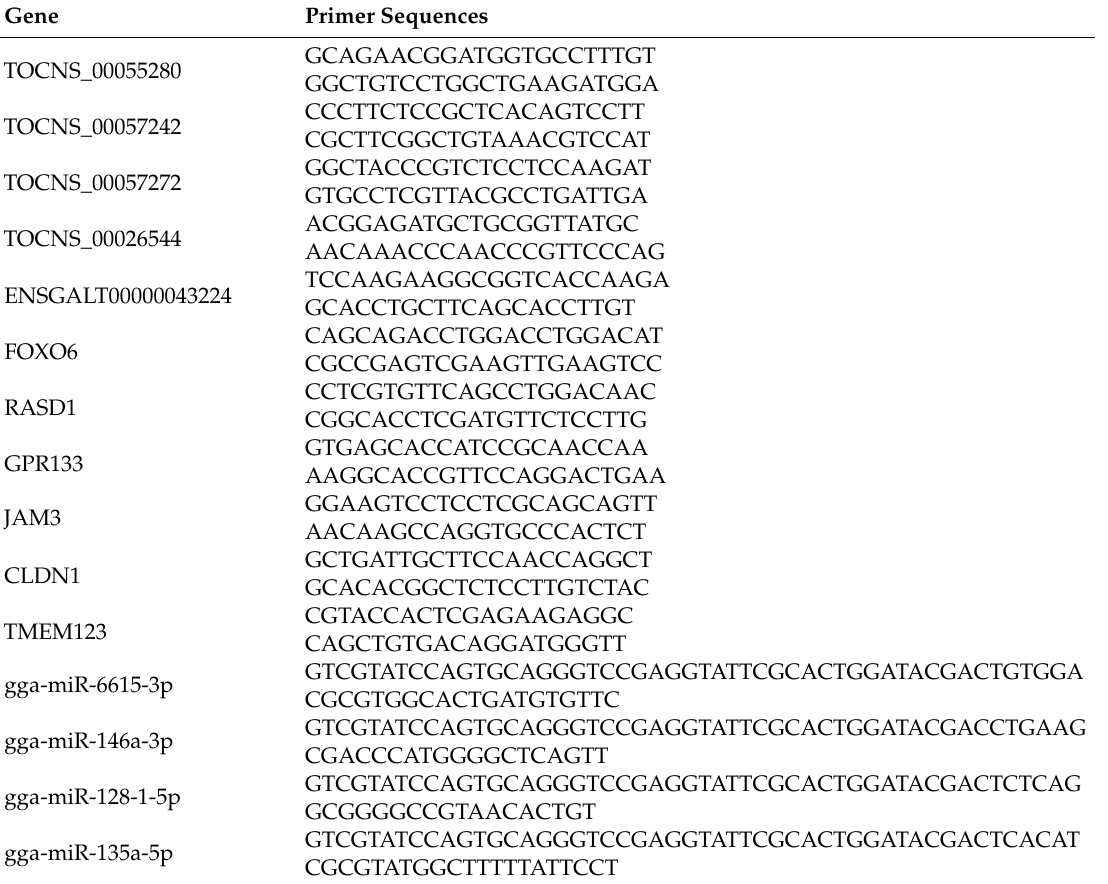
Table 1. Primers for